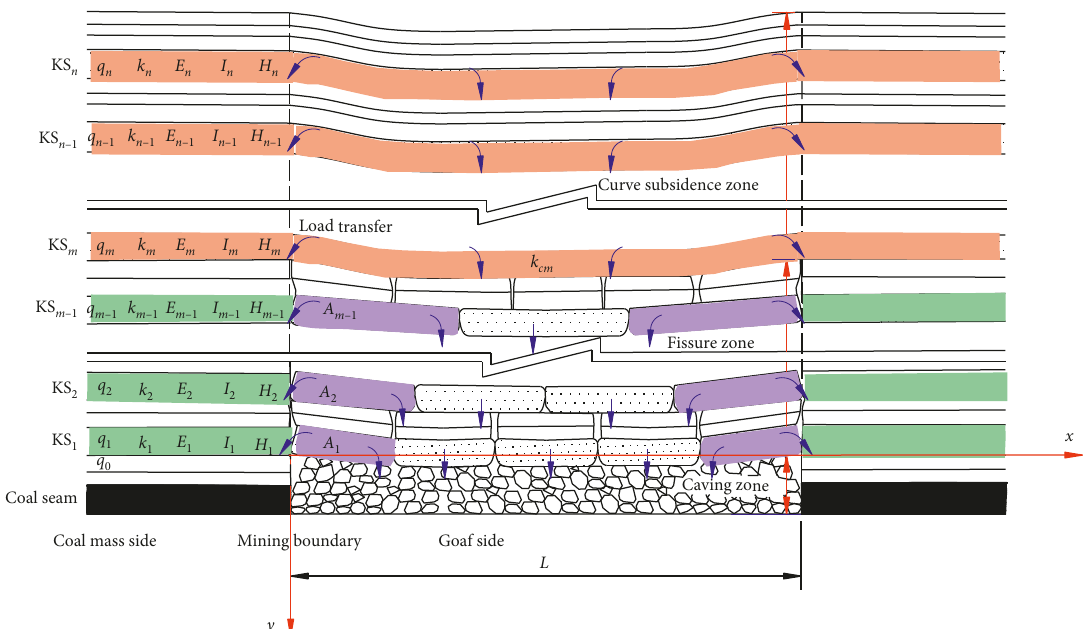
Figure 5: Mechanical model for abutment pressure